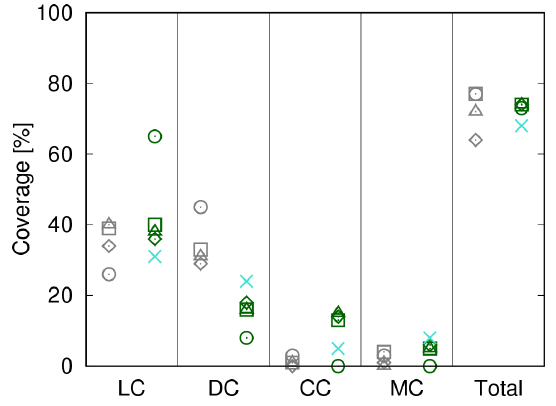
Figure 9. Comparison of biocrust cover estimated by LiBry to observations at four different field sites at Soebatsfontein, South Africa. Absolute values of cover of the four different biocrust types and also total cover are shown. The abbreviations on the x axis stand for light cyanobacteria-dominated (LC), dark cyanobacteria-dominated (DC), chlorolichen-dominated (CC), and moss-dominated (MC) biocrusts. The field sites are distinguished by different geometric symbols. Grey symbols on the left side of each column denote field observations, while green symbols on the right correspond to model estimates based on climate data measured at the field sites. Blue crosses show model estimates obtained from global climate data for the Soebatsfontein